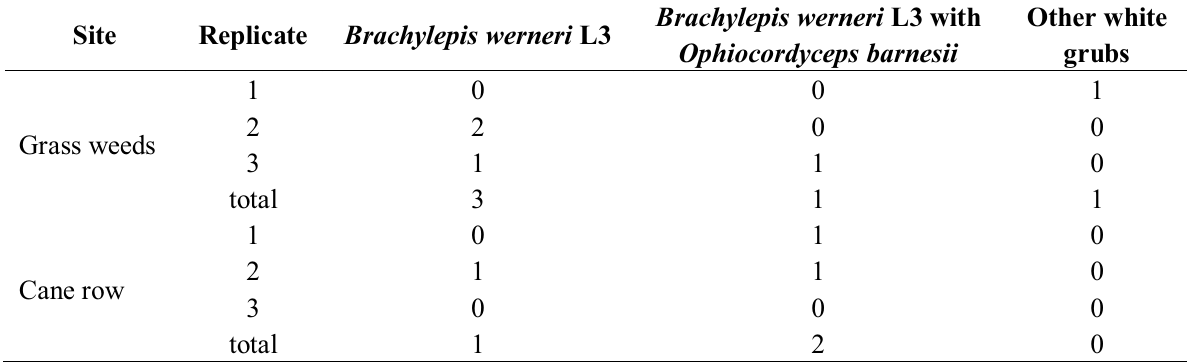
Table 8. Pit samples (0.5 × 0.5 × 0.5 m) to compare white grub incidence under grass weeds and adjacent cane row in LS10/11, October